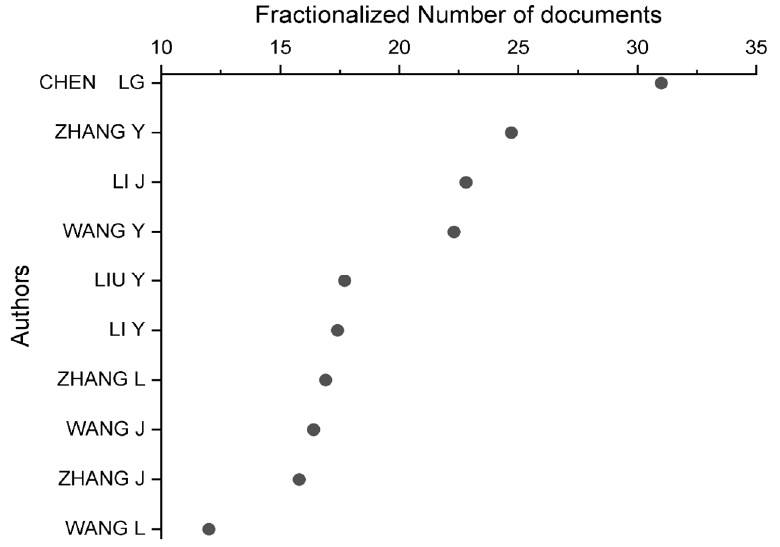
Figure 8. Most relevant authors.